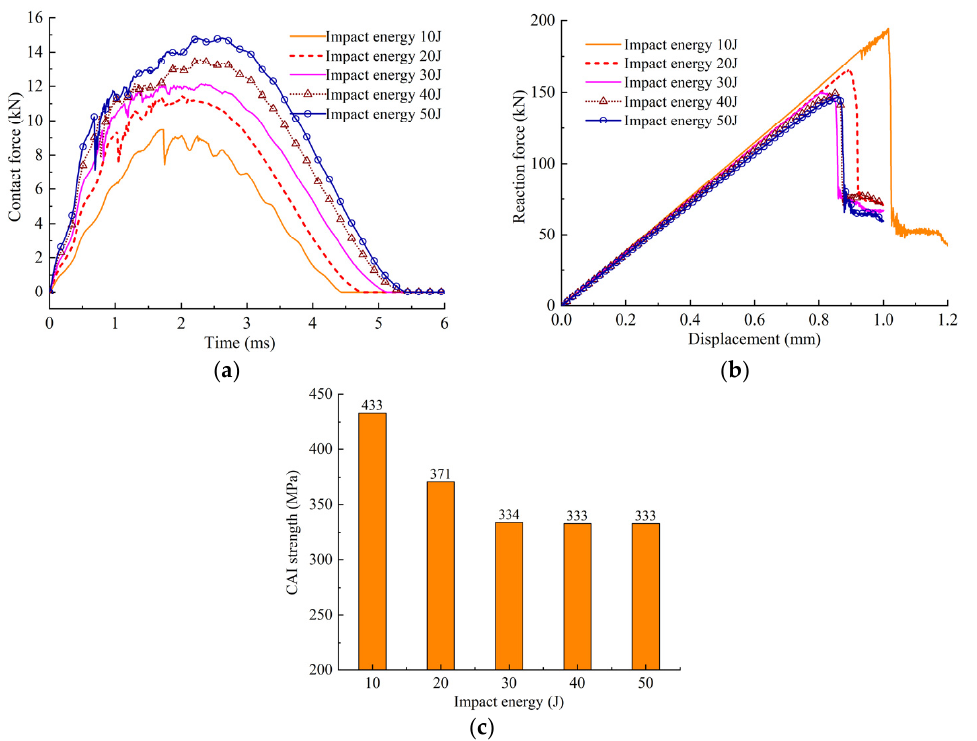
Figure 15. The impact and compression response under different impact energy conditions. ( a ) The contact force curves. ( b ) The compression load versus displacement curves. ( c ) CAI strength with different impact energy.